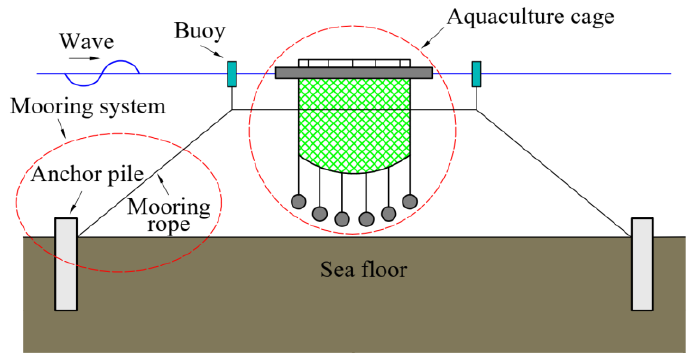
Figure 1. Floating net cage aquaculture system.